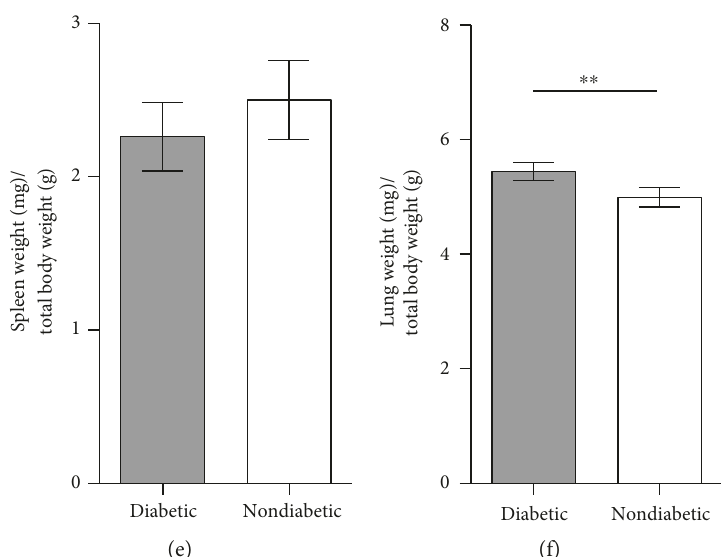
Figure 2: Organ-to-body weight ratio of diabetic and control mice. (a) Weight ratio measurements at the end of the study of diabetic ( n = 12 ) and nondiabetic ( n = 12 ) mice in the (a) kidney, (b) heart, (c) liver, (d) brain, (e) spleen, and (f) lung. Student ’ s t -test was used to test the di ff erence between groups, which was indicated in the fi gure when signi fi cant. ∗ p < 0 05 , ∗∗ p < 0 01 , ∗∗∗ p < 0 001 . Data is given in mean with standard deviations (SDs).